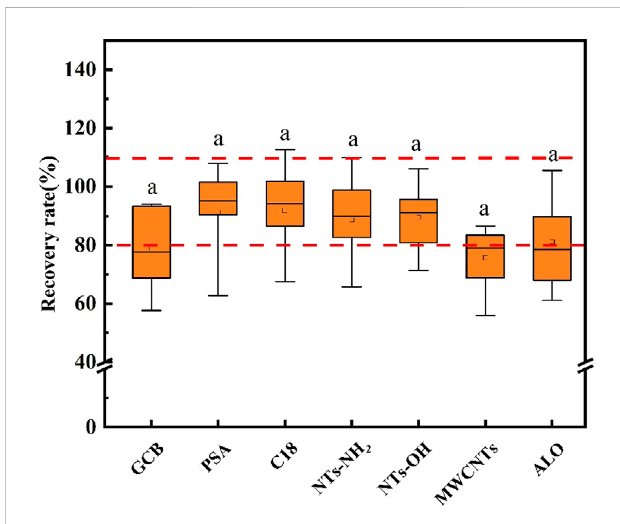
FIGURE 2 Puri fi cation effects of different sorbents in nine matrices.